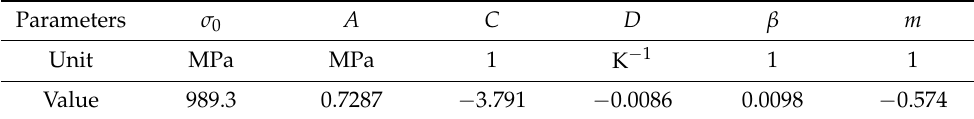
. ε 0 = 0.002, T 0 = 298 K, and T m = 1727 K) [12].